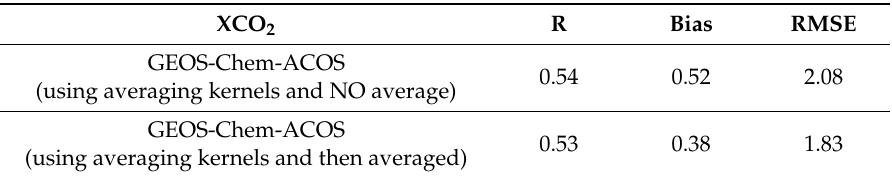
Figure 14. The frequency histogram of differences (standard deviations) between GOSAT XCO 2 and the corresponding averaged XCO 2 at 2° × 2.5° grids on the global land in 2010. Table 5. Comparison between XCO 2 from GEOS-Chem and GOSAT/ACOS in 2010. It is noted that comparison of averaged XCO 2 between GEOS-Chem and GOSAT/ACOS observations at 2° × 2.5° grids was conducted after using averaging kernels.